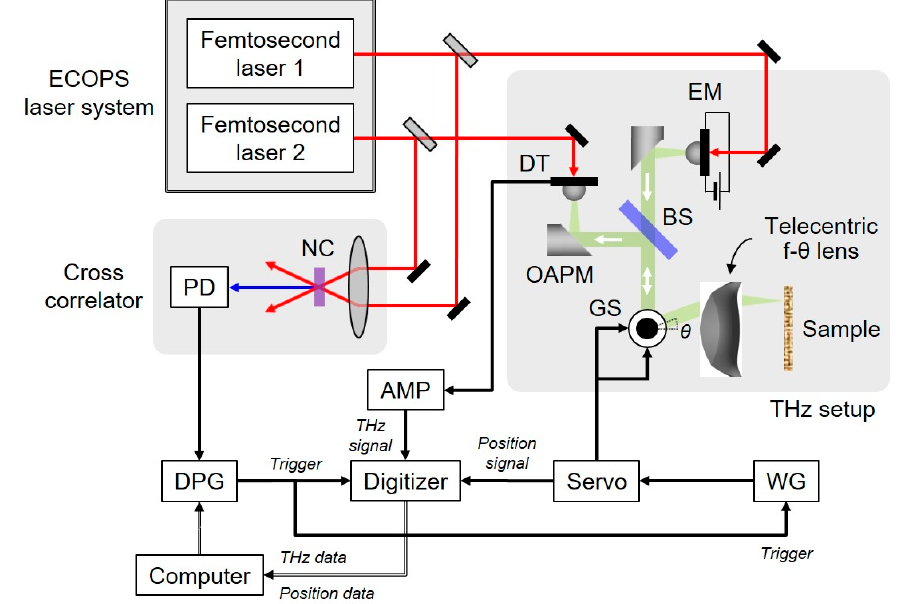
Figure 1. Schematic diagram of our time-domain THz tomography system. PD: photodetector, NC: nonlinear optical crystal, EM: THz emitter, DT: THz detector, OAPM: off-axis parabolic mirror, BS: Si beam splitter, GS: 2D galvanometer scanner, DPG: digital delay/pulse generator, WG: waveform generator, Amp: current preamplifier.